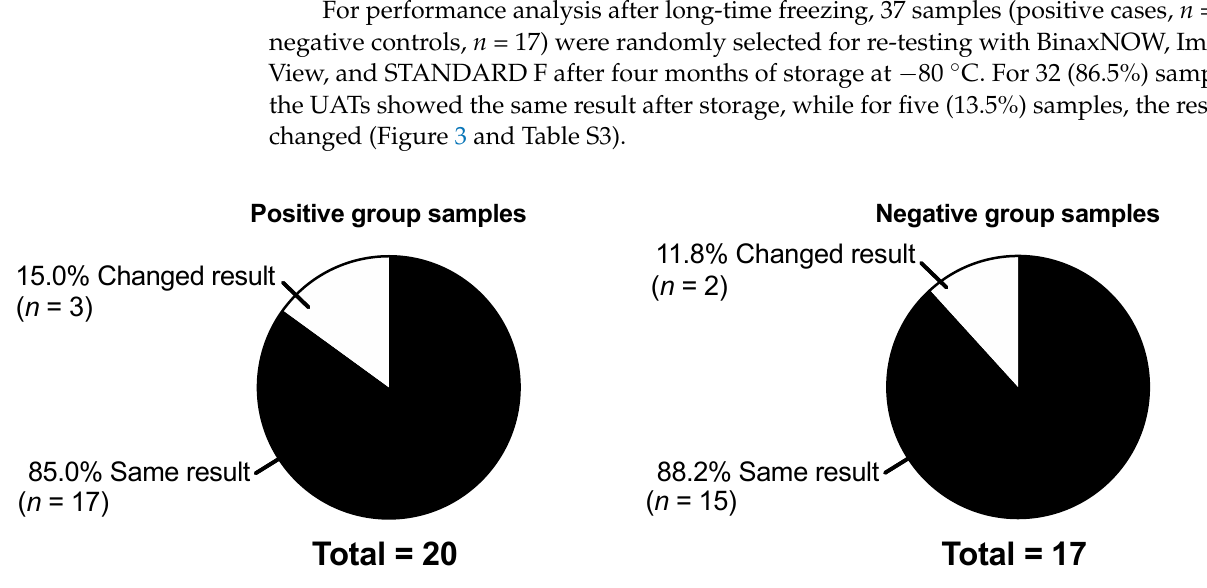
Figure 3. Proportion of samples with the same result, or a changed result, in one or more of the four Streptococcus pneumoniae urine antigen tests after four months of storage at − 80 °C.